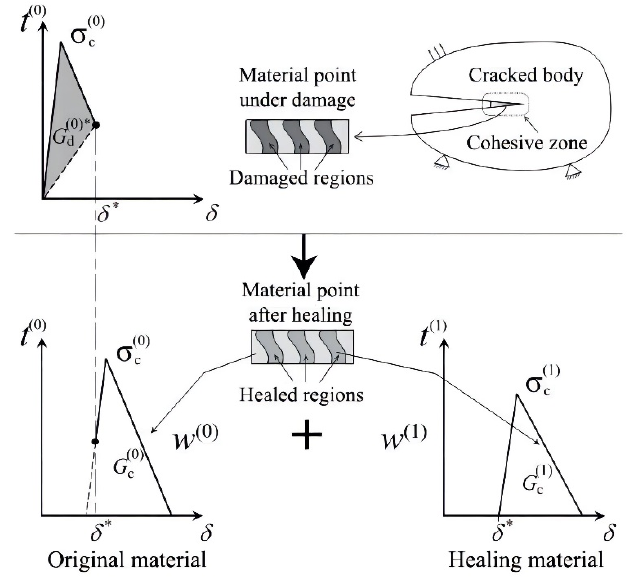
Figure 13. The composite cohesion relationship of the crack-healing model was obtained by the traction–separation law of the original material and the healing material [81].